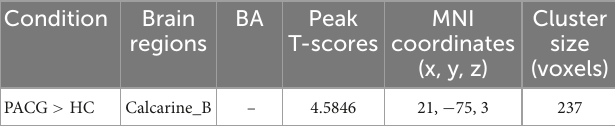
TABLE 3 Different dFC values in the right V1 between two